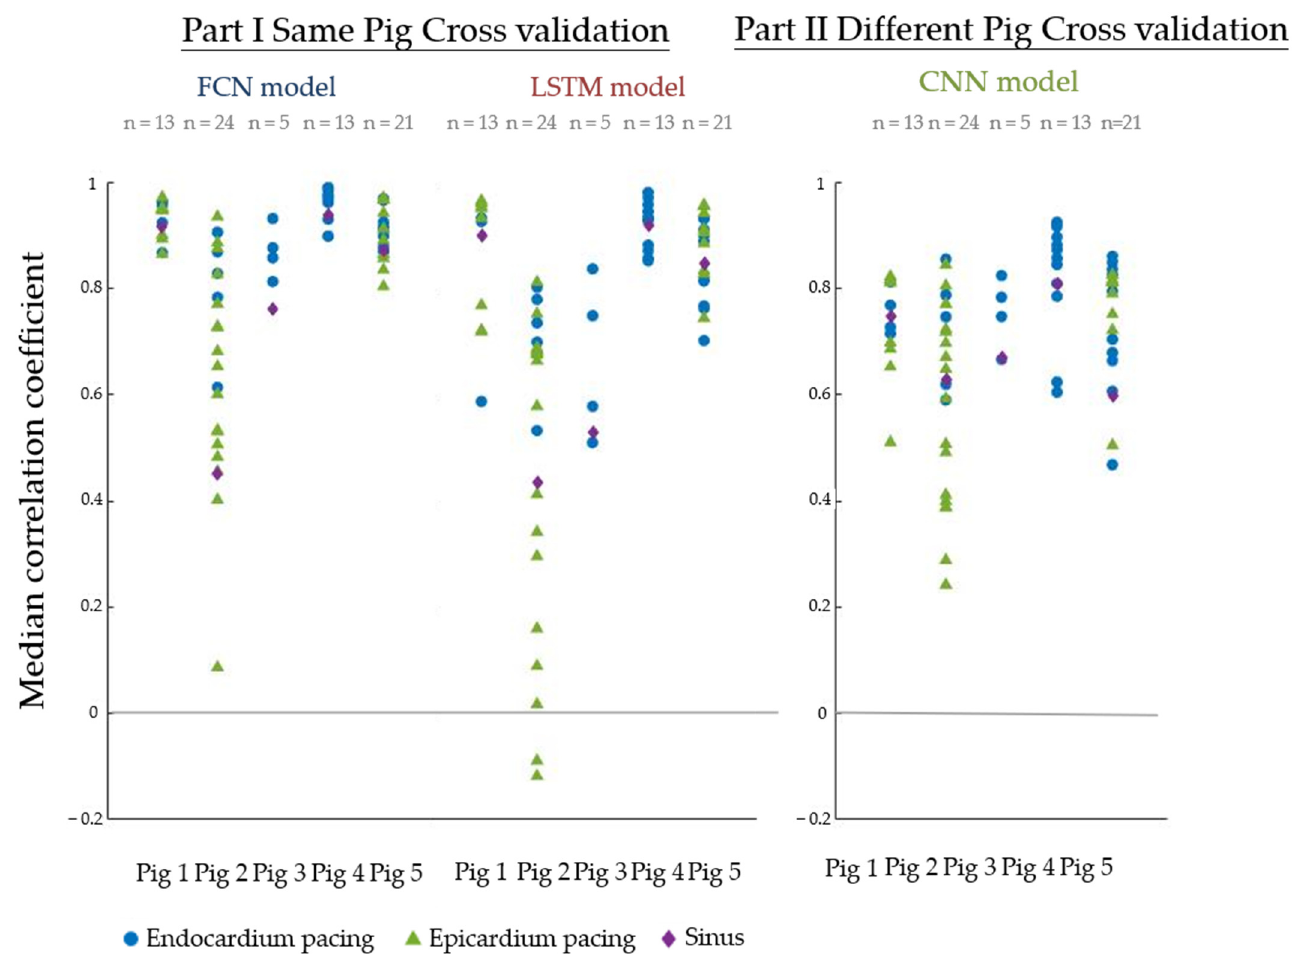
Figure 12. Cross-validation results. ( Left ): Cross-validation results using data from the same pig. ( Right ): Cross-validation results using data from all pigs. Each dot represents the median correlation coefficient across 239 epicardial nodes.